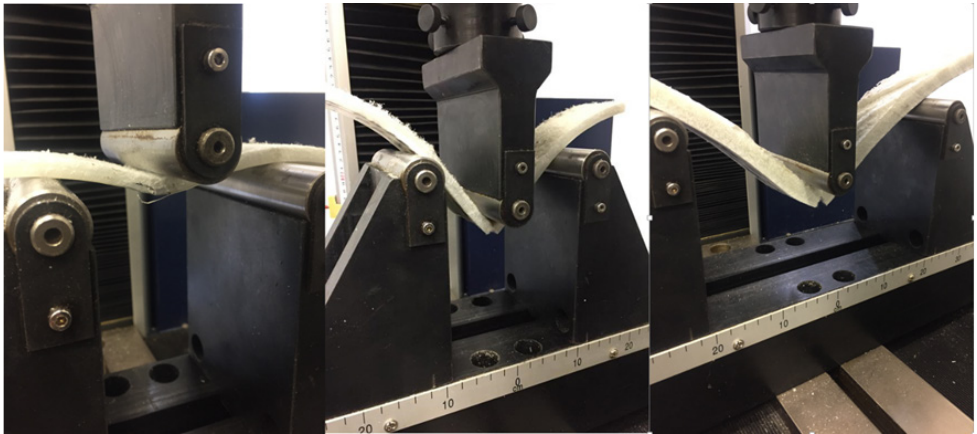
Figure 13: The mechanism of the sample’s destruction.